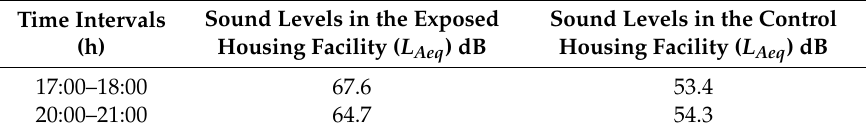
Table 2. Sound levels in the exposed and control housing facility.